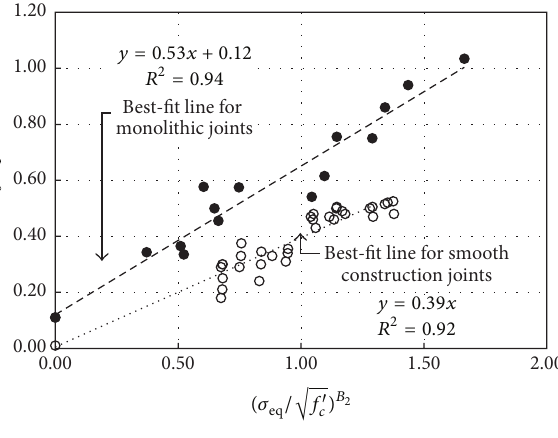
Figure 3: Regression analysis for 𝑆 0